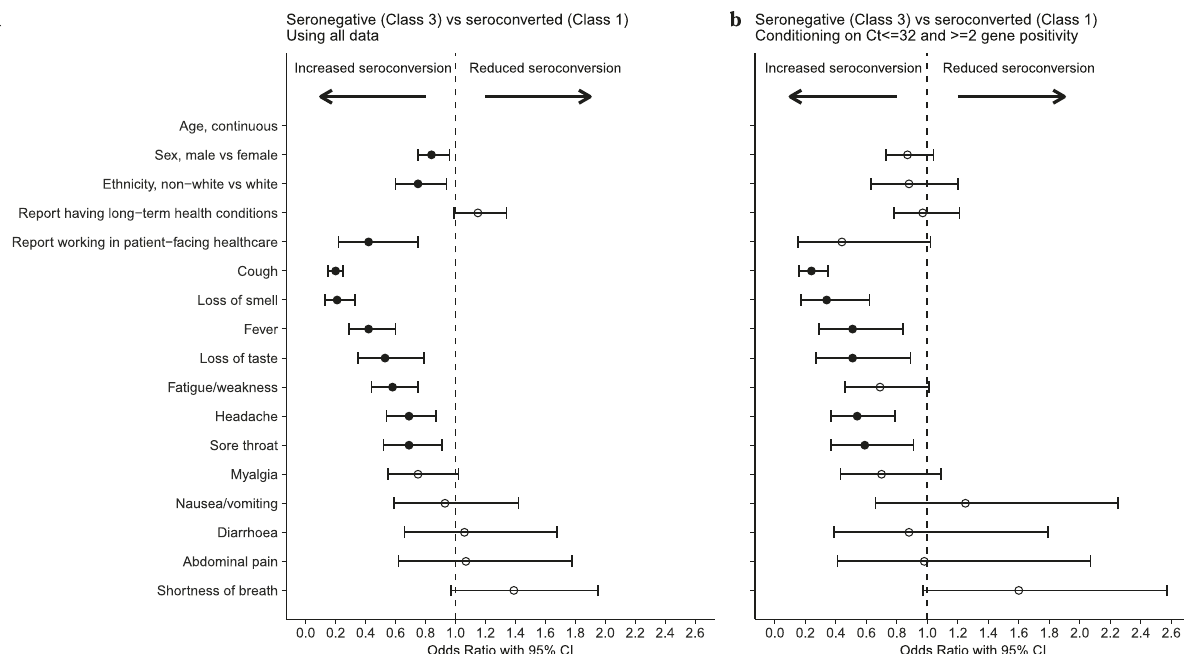
Fig. 3 Odds ratio with 95% con fi dence intervals from logistic regression comparing seronegative vs. seroconverting (Class 3 vs. Class 1) using demographic factors and individual symptoms that would be available without a positive test result. a Using all data from Class 3 ( N = 1742) vs. Class 1 ( N = 4683). b Restricting Class 3 to those with Ct value ≤ 32 and ≥ 2 genes detected ( N = 595) to decrease the impact of potential false-positive swab tests. Age was fi tted using natural cubic spline with one internal knot placed at 50 years and two boundary knots at 20 and 80 years. Effect of age is presented in Supplementary Fig. 4. The 95% con fi dence intervals are calculated by prediction ± 1.96 × SE of the prediction; solid dots indicate estimates with p -values < 0.05, whereas hollow dots indicate those with p -values ≥ 0.05. Numbers of odds ratio, 95% CI and p -values are presented in Supplementary Table 3.